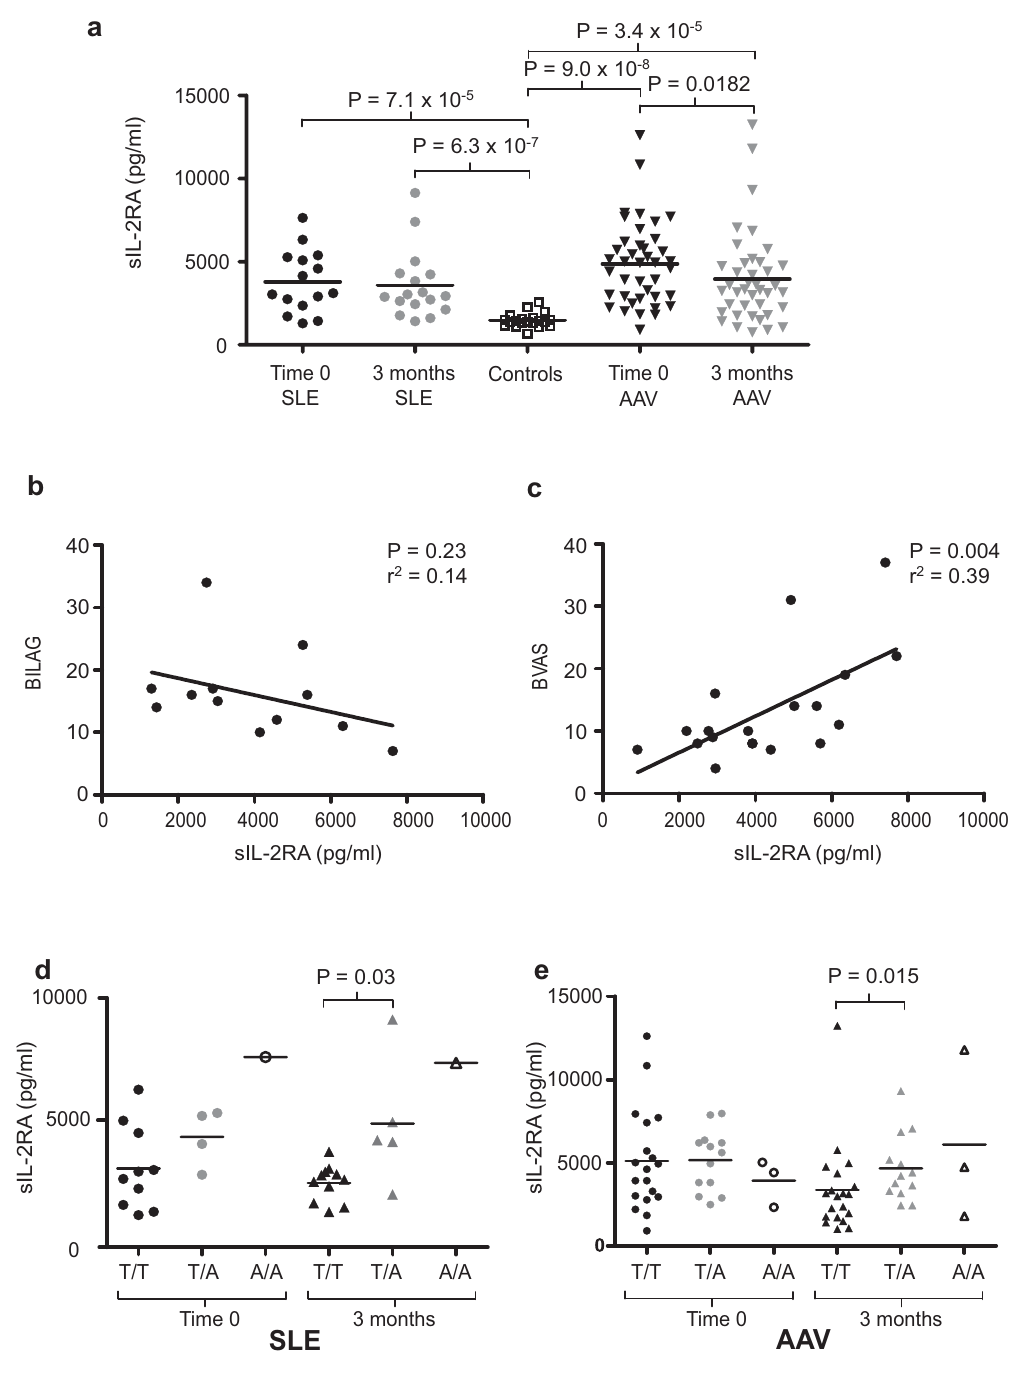
Figure 2 Serum soluble IL-2RA in SLE and AAV and its relationship with disease activity and genotype at rs11594656 . (a) A comparison of SLE and AAV soluble IL-2RA (sIL-2RA) at time 0 and 3 months compared with controls, as assessed by ELISA. Each dot represents a patient. (b, c) Correlation between disease activity and sIL-2RA. (BILAG for SLE; BVAS for AAV; see supplementary information). r 2 and P values from linear regression modelling are shown. (d, e) sIL-2RA levels stratified by genotype at rs11594656 at both time 0 and 3 months for SLE (d) and AAV (e). P values for panels (a), (d) & (e) were generated using the Mann-Whitney